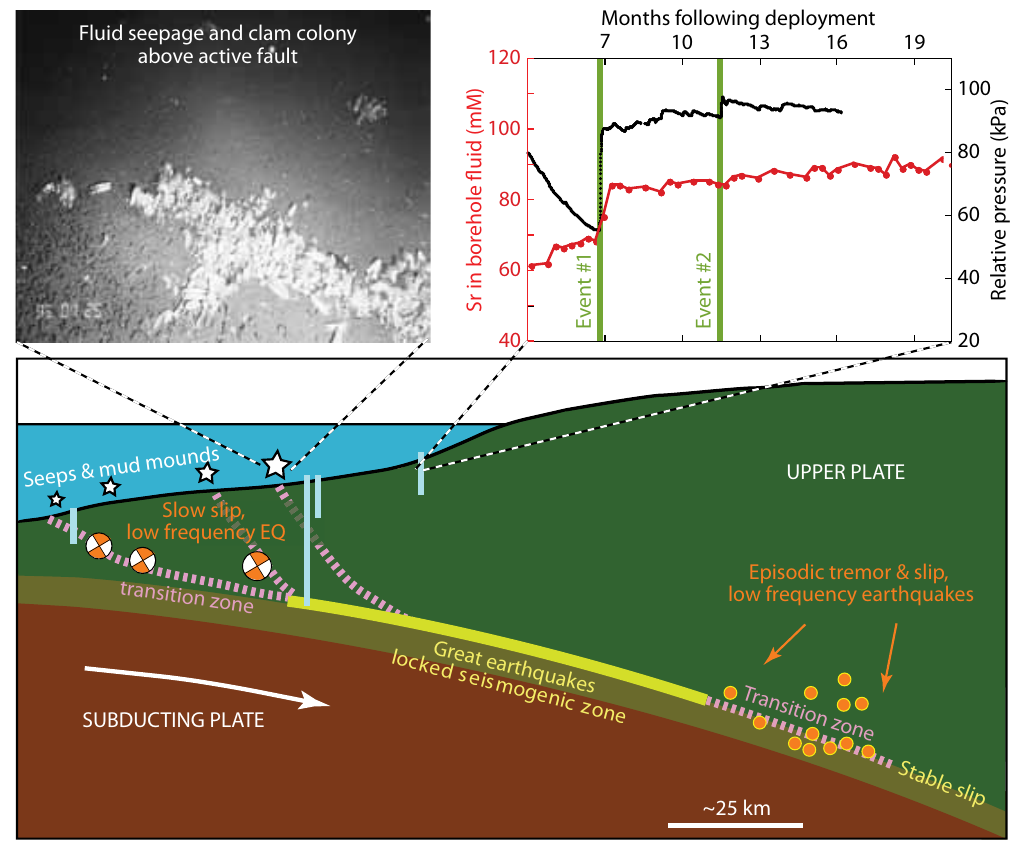
figure 5.2. schematic cross section of a subduction zone showing the locations and diverse styles of earthquake slip observed along subduction megathrusts. The locations and sense of slip for slow-slip events and very-low-frequency earthquakes (vlfe) in the shallow subduction zone outboard of the locked seismogenic zone (orange and white symbols) are consistent with their occurrence along major splay faults within the upper plate (after ito and obara, 2006; obana and Kodaira, 2009). These splay faults are associated with cold seeps at the seafloor (photo, top left), suggesting that fluids may play a role in their slip behavior. The source regions of shal- low slow slip and vlfe events, along with the shallowest portion of the megathrust that slips coseismically (yellow line), are likely within the reach of ocean drilling. deep slip behavior along the subduction interface includes episodic tremor and slip, as well as slow-slip events (orange circles). monitoring of seismicity and fluid conditions in boreholes (shown schematically in blue) is an essential com- ponent in characterizing and understanding these newly discovered phenomena. photo at top from ogawa et al. (1996); schematic diagram adapted from saffer and Tobin